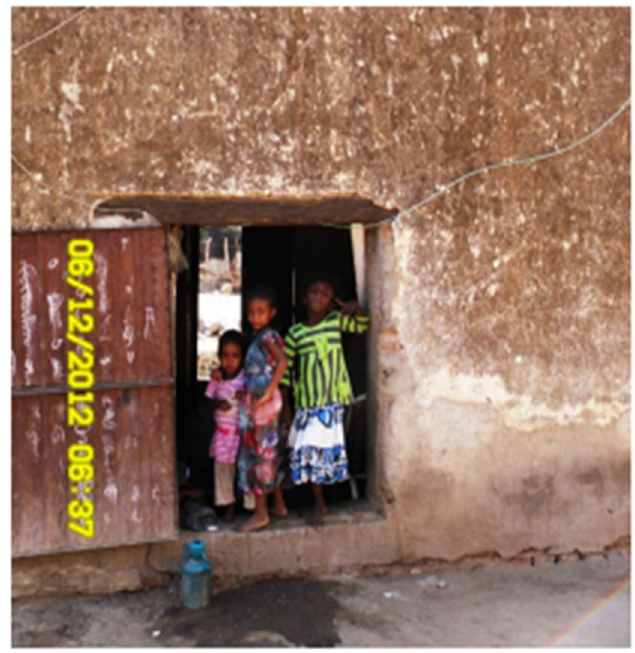
Figure 11. Old thick brick houses with doors opposite one another.